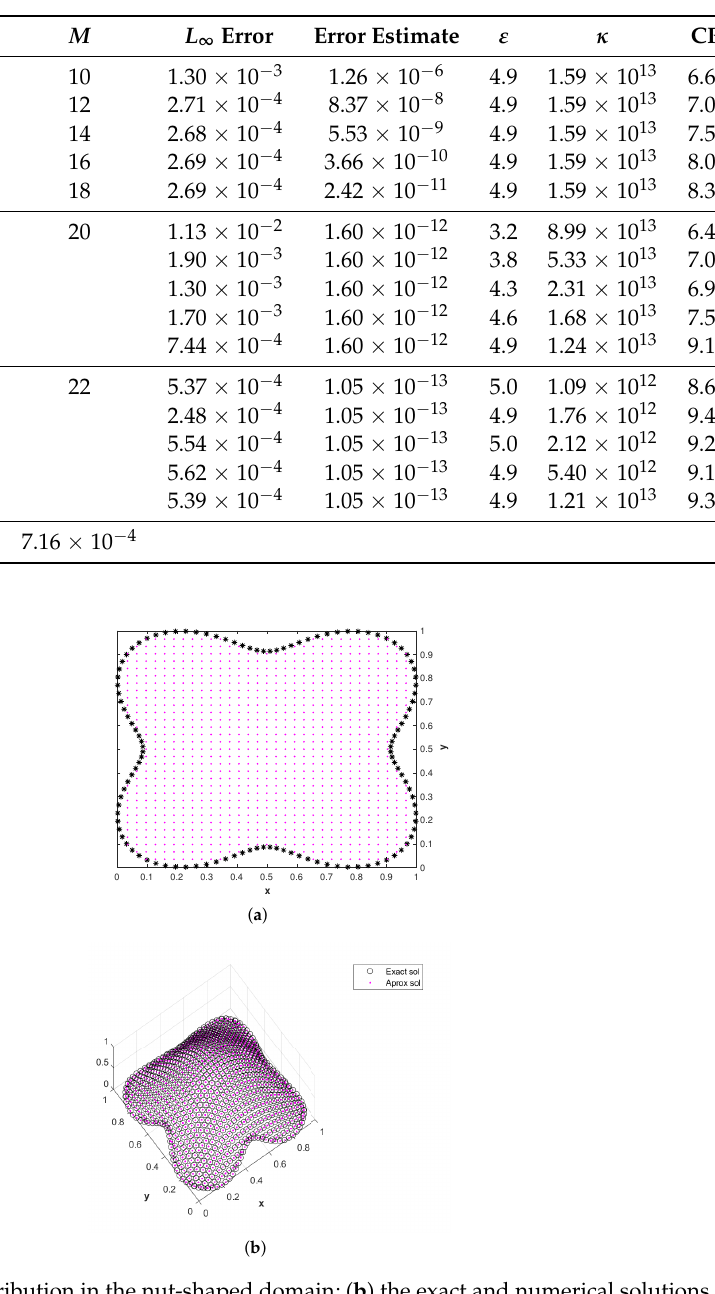
Table 2. Numerical results for the FPIDEs in nut-shaped domain.